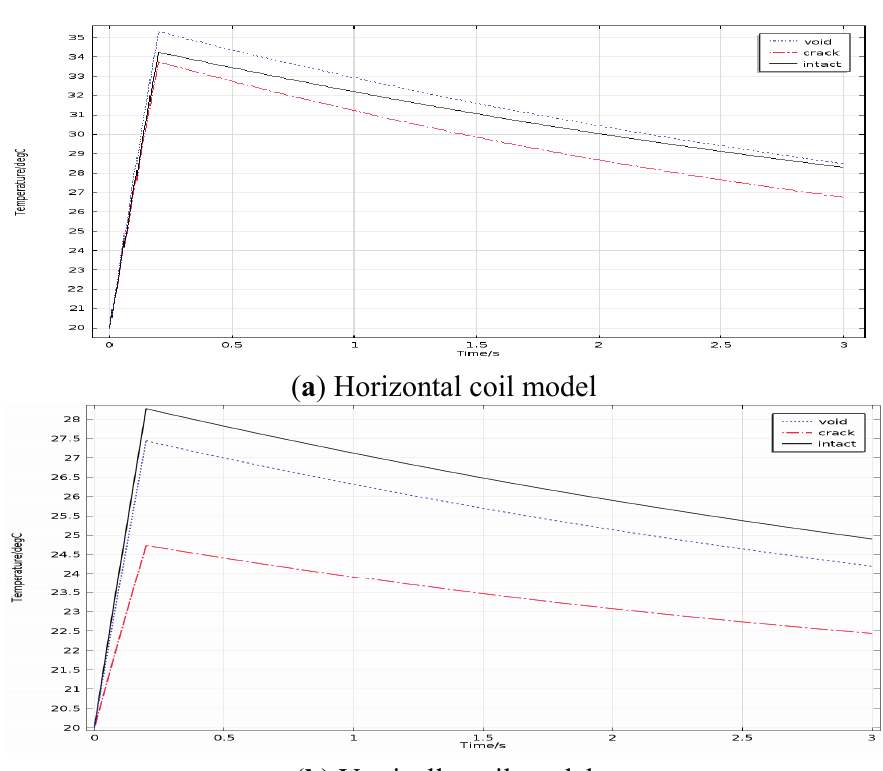
Figure 10. Temperature curves for each simulation